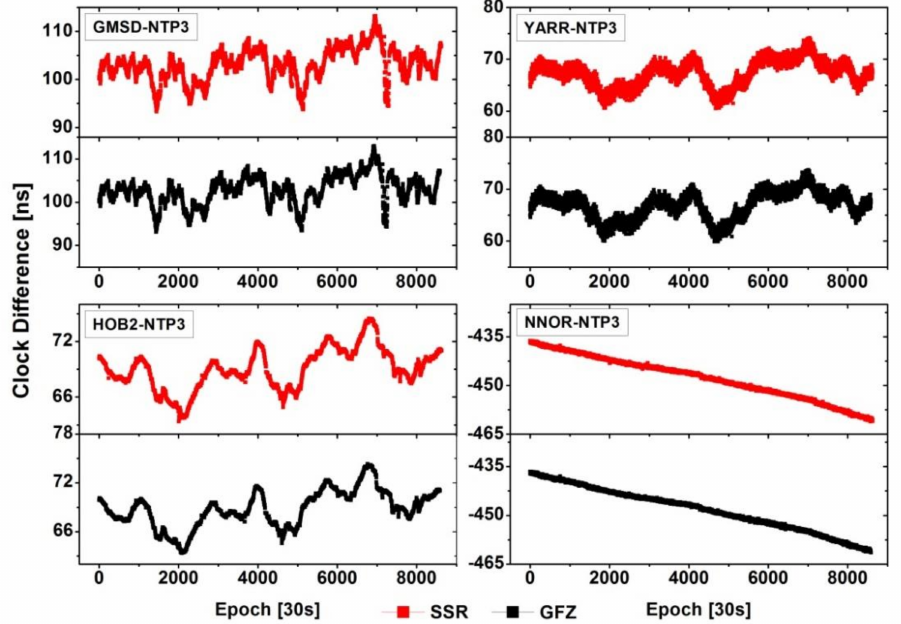
Figure 5. GPS results for SSR and GFZ